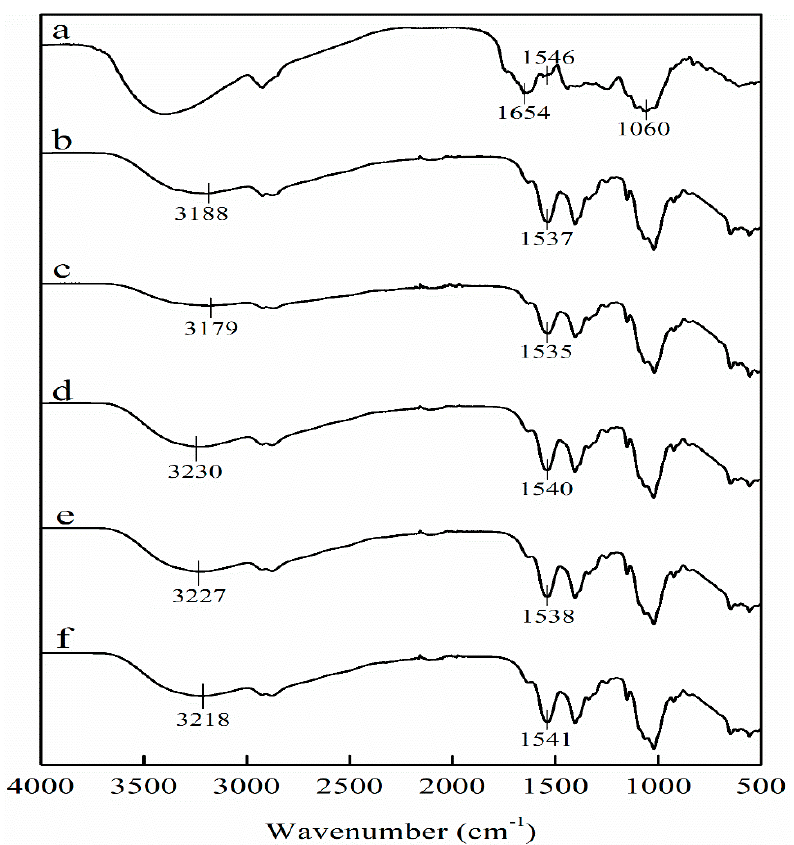
Figure 3. FT-IR spectra of LPP ( a ), CHS film ( b ), CHS-2.5LPP ( c ), CHS-5LPP ( d ), CHS-7.5LPP ( e ), and CHS-10LPP ( f ).